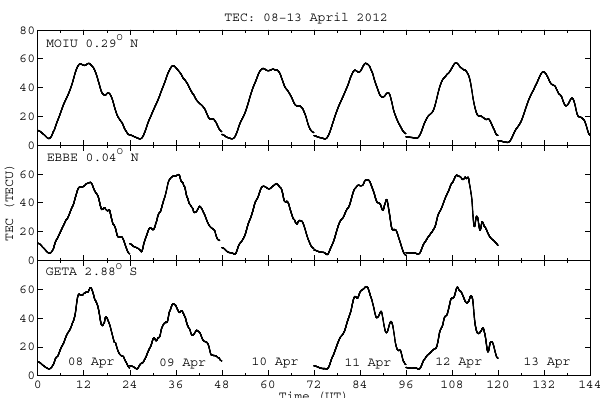
Figure 4. TEC measurements from African low-latitude stations MOIU, EBBE and